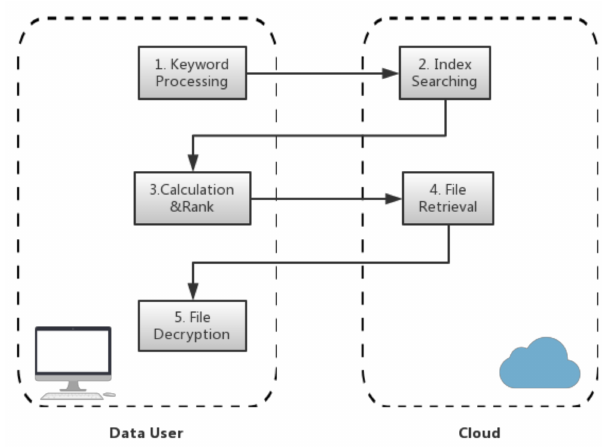
Figure 2. Process of Encrypted File Search and